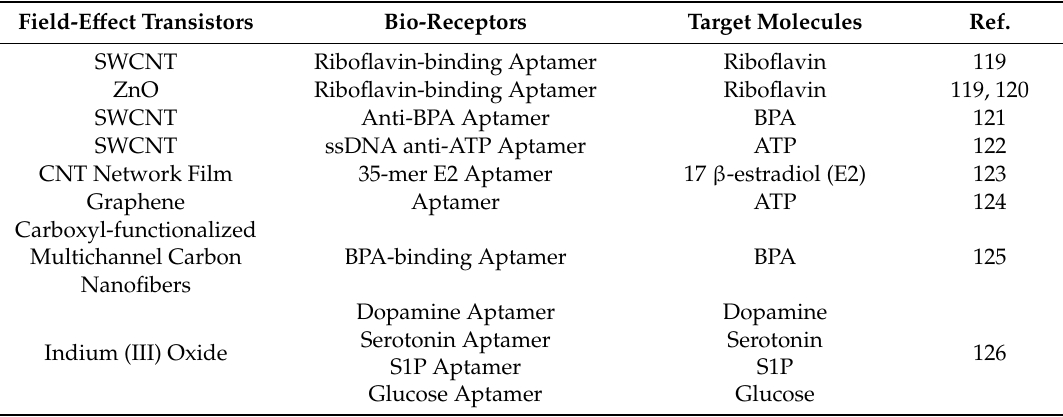
Table 1. Development of FET aptasensors detecting small